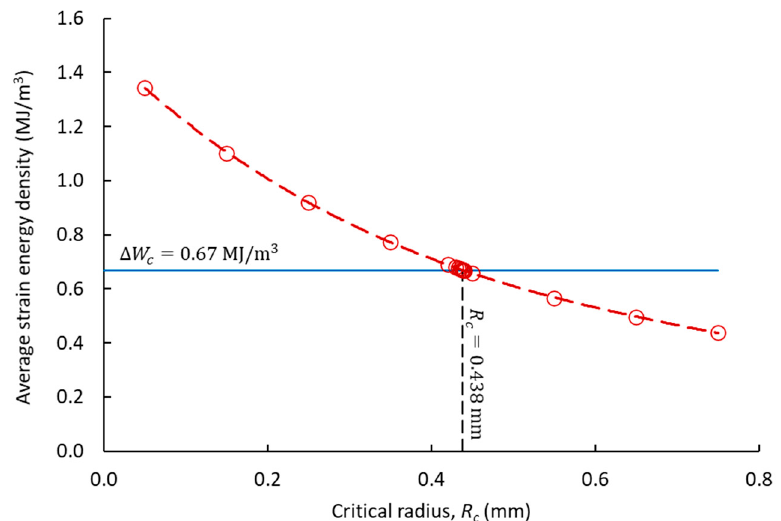
Figure 7. Determination of the critical radius.